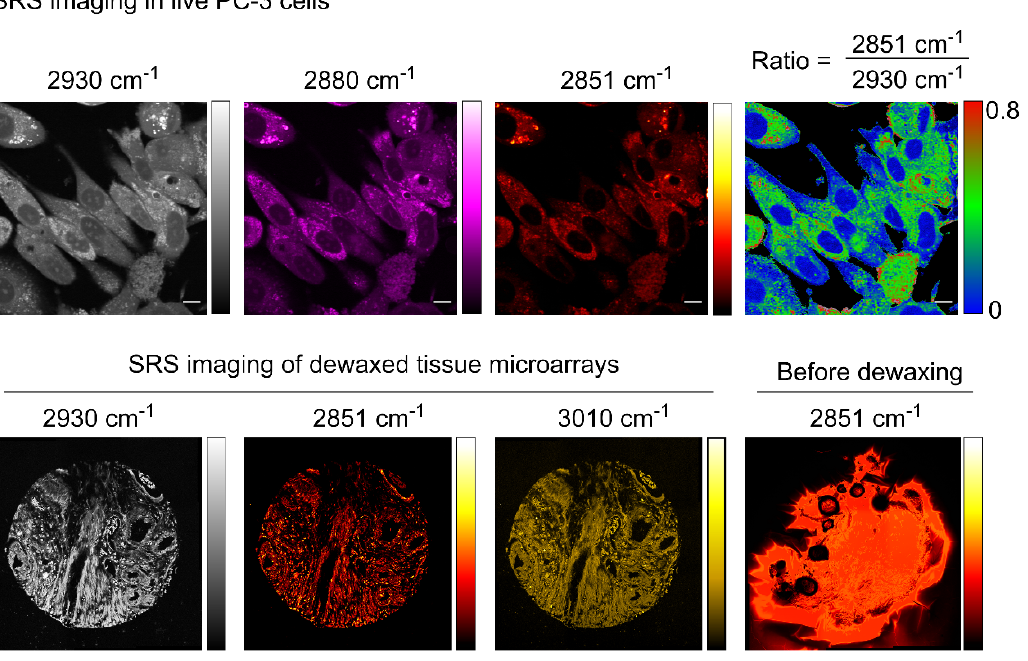
Figure 5. SRS imaging of live PC ‐ 3 cells. Images were acquired at 2930 cm − 1 (CH 3 symmetric stretch, proteins), 2880 cm − 1 (CH 2 asymmetric stretch, proteins and lipids) and 2851 cm − 1 (CH 2 symmetric stretch, lipids). A ratiometric image of the CH 2 /CH 3 (2851 cm − 1 /2930 cm − 1 , intensity scale 0–0.8